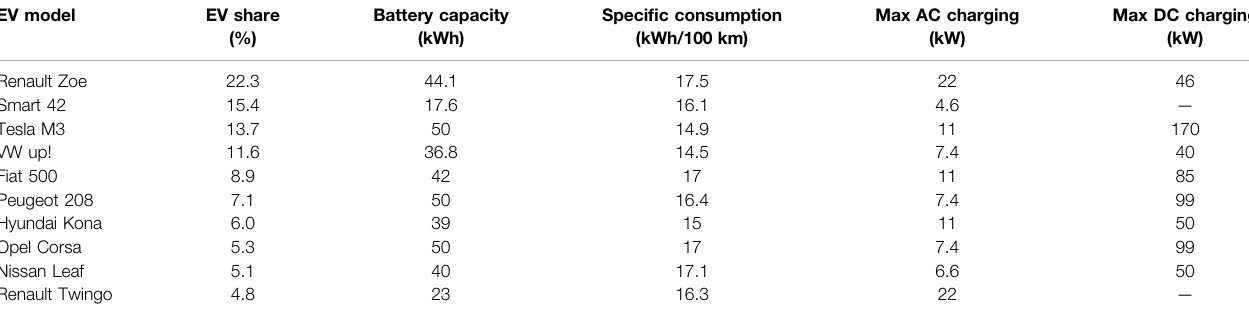
TABLE 1 | Data and parameters of the EVs reference population (top 10 best sellers registered in Italy in 2020). EV